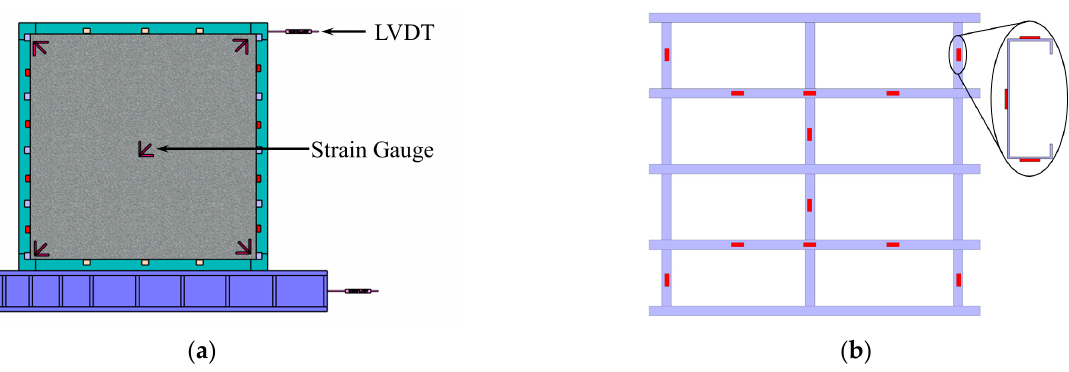
Figure 6. Schematic of the measurement layout: ( a ) the arrangement of strain gauges on the composite wallboard; ( b ) the arrangement of strain gauges on the C-shaped steel.